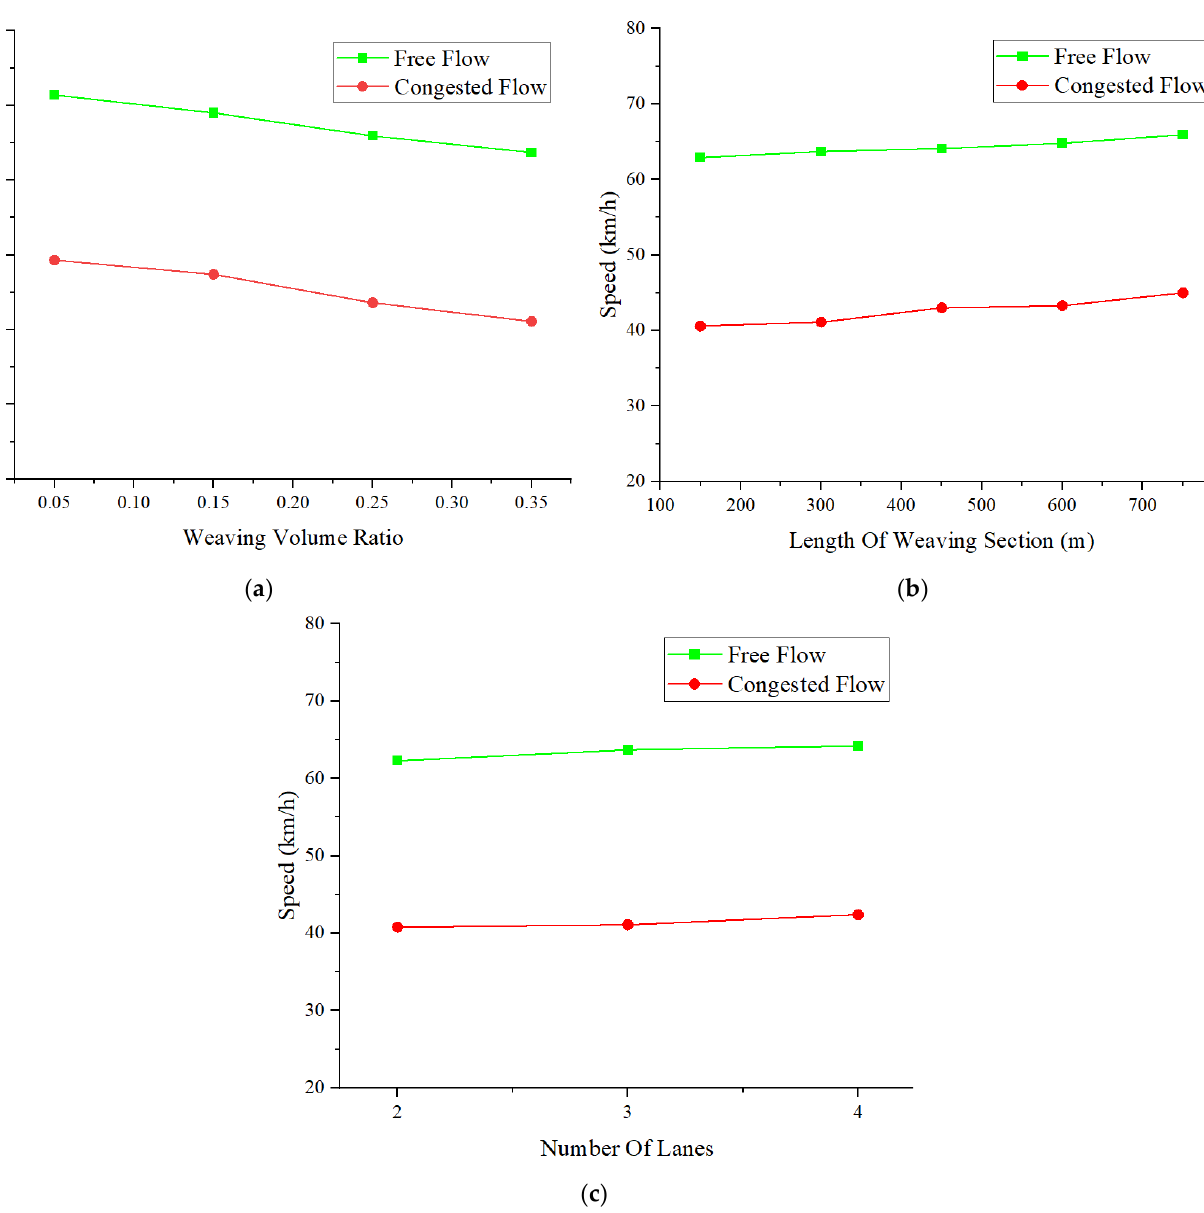
Figure 4. Speed catastrophe boundary in different scenarios. ( a ) Weaving volume ratio—catastrophe boundary; ( b ) Length of weaving section—catastrophe boundary; ( c ) Number of lanes—catastrophe boundary.